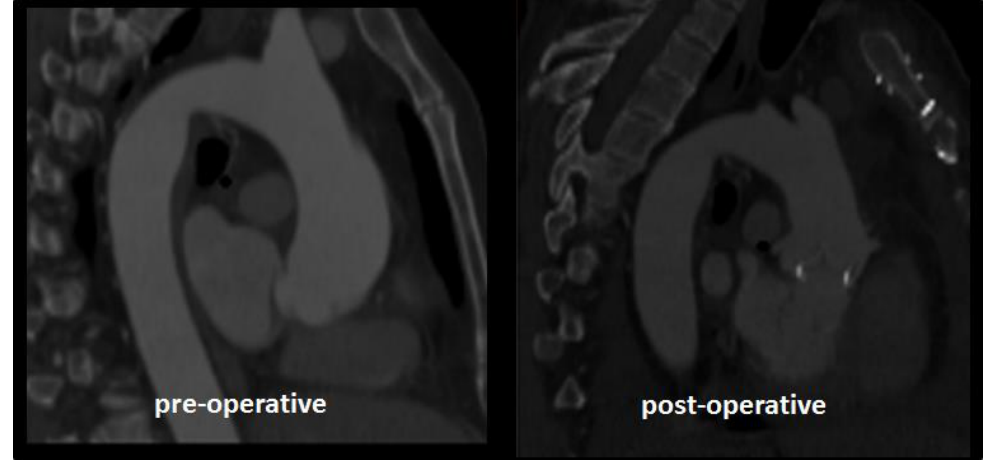
Figure 1. Pre- and post-operative CT images showing the change in the aortic shape induced by surgical